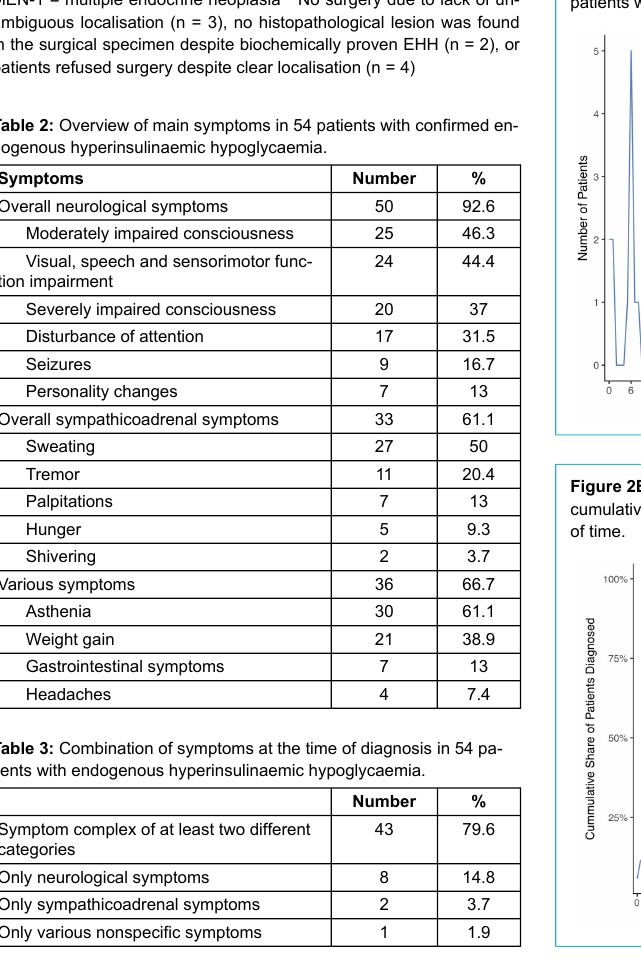
Figure 2A: Interval between onset of symptoms and diagnosis: distribution of the time to diagnosis. On the y-axis the number of patients which had been diagnosed at a given time (x-axis).